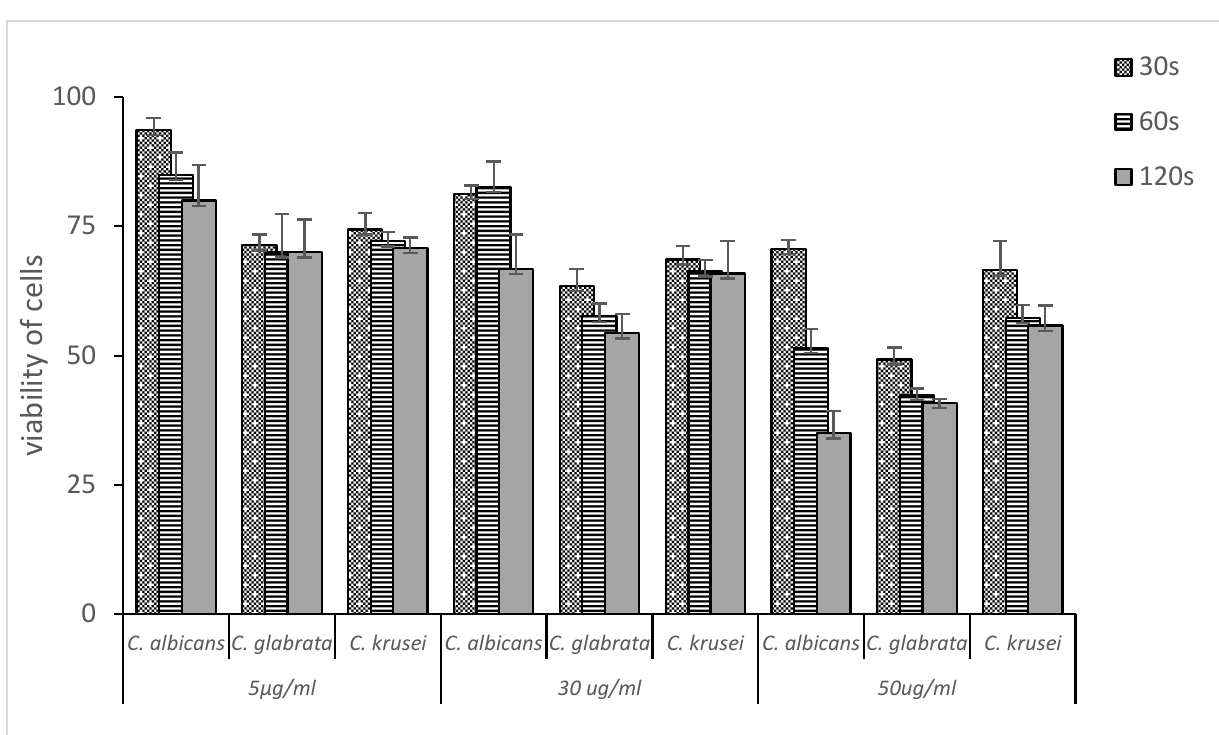
Figure 5. The effect of different exposure times (30 s–120 s) of ozonated water at three concentrations (5 µ g/mL, 30 µ g/mL, and 50 µ g/mL) on cell viability (percentage of viability). Comparison between fungal strains C. albicans ATCC 10,231, C. glabrata ATCC 2001, and C. krusei ATCC